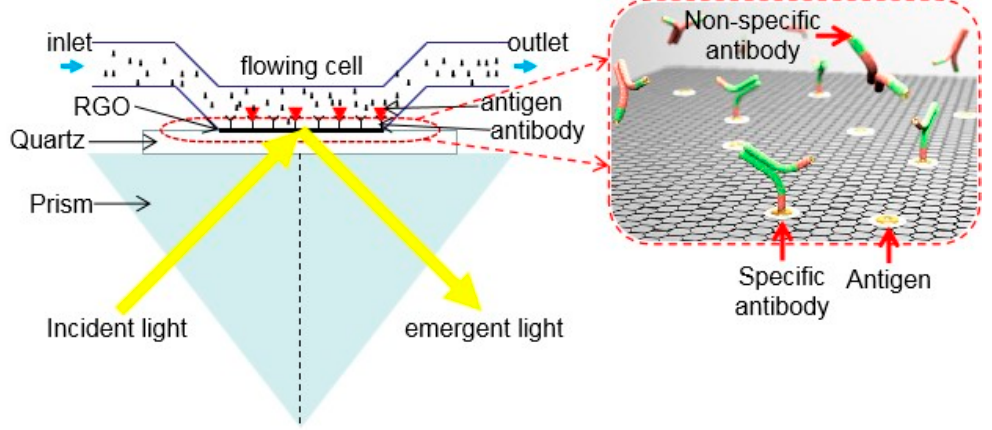
Figure 8. The schematic of reduced graphene oxide (RGO)-based optical sensor.